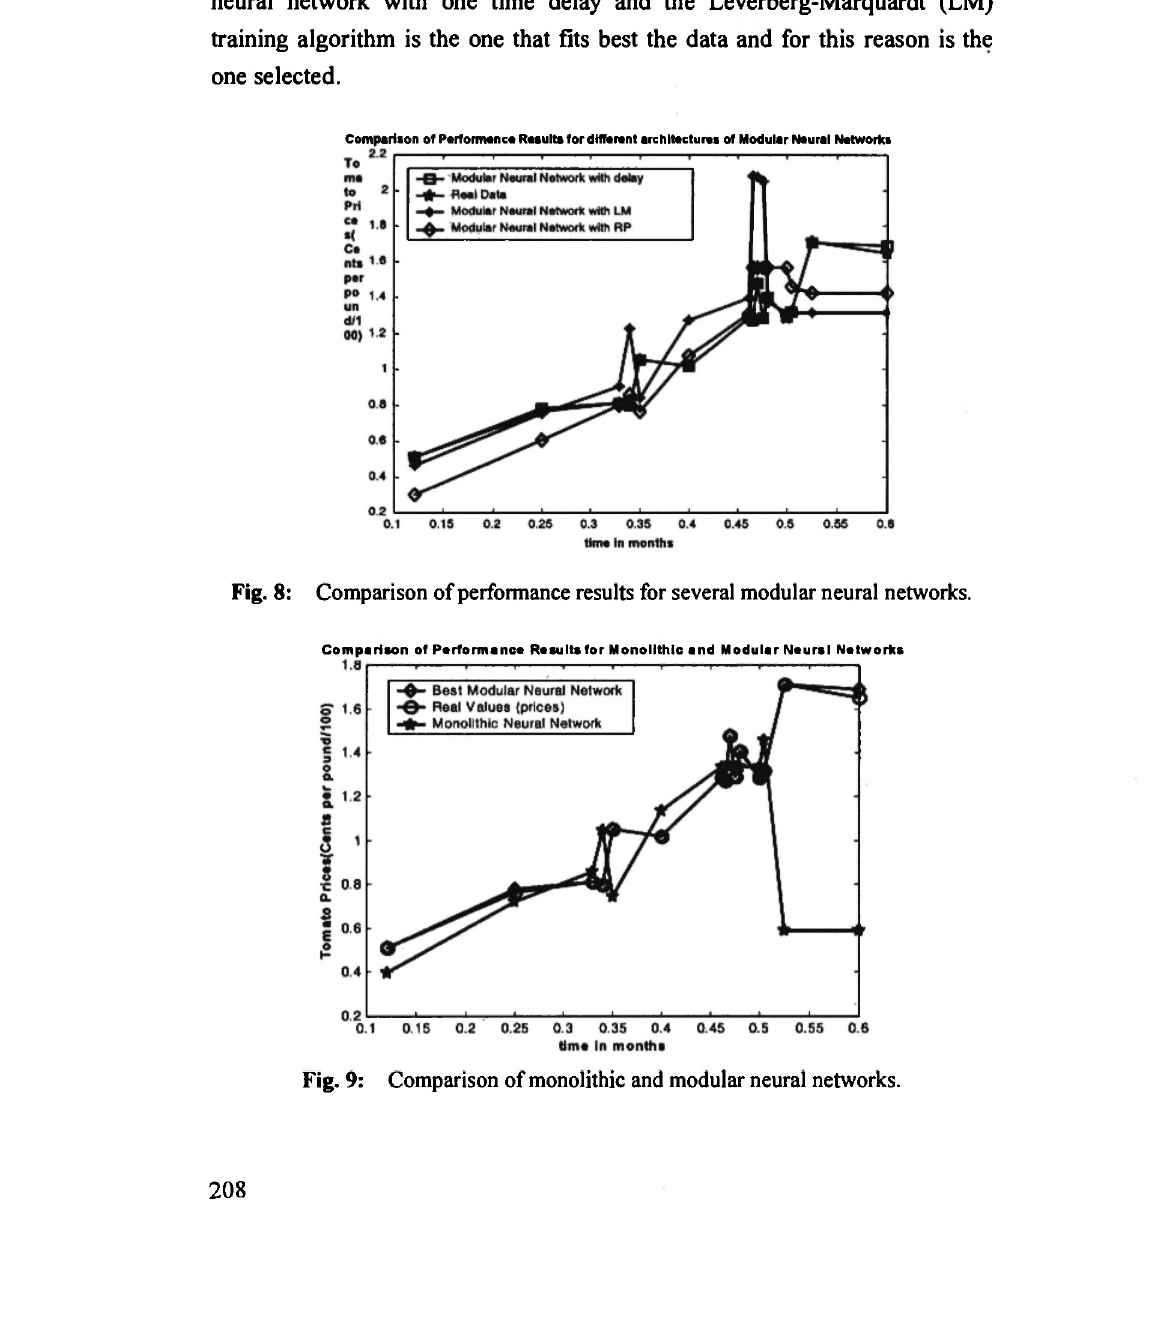
Fig. 9: Comparison of monolithic and modular neural